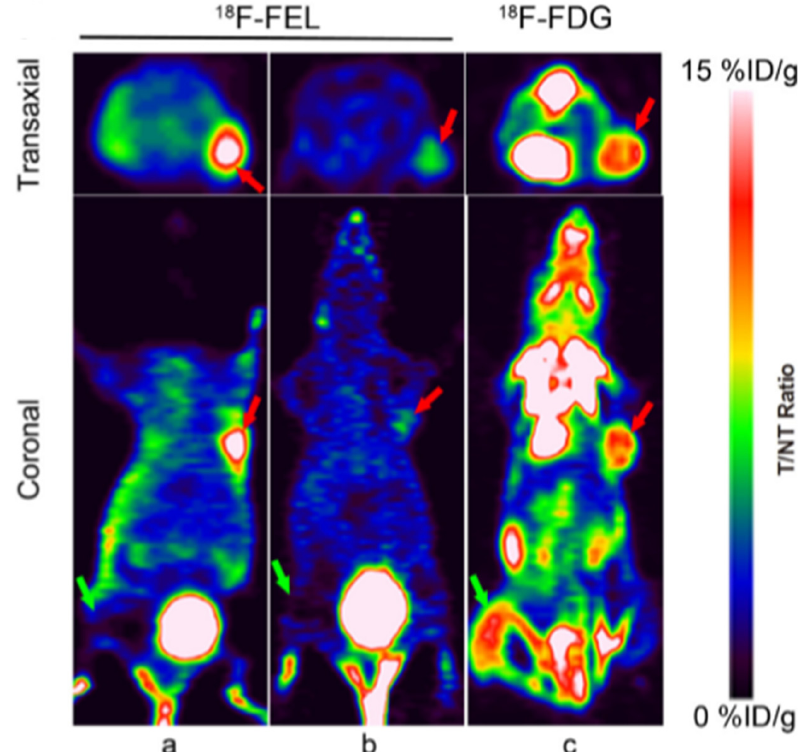
Figure 3. PET imaging of T3M4 tumors-bearing and inflammation nude mice 60 min after injection of 18 F-FEL ( a ) and 18 F-FDG ( c ). PET images 60 min after co-injection of β -D-lactose as competitor ( b ). Tumors are marked by red arrows and inflammatory lesions are marked by green arrows. Tumors were delineated 60 min after injection of 18 F-FEL, while low background and absence of accumulation was present in inflammatory tissue. Reprinted with permission from Ref [78]. Copyright